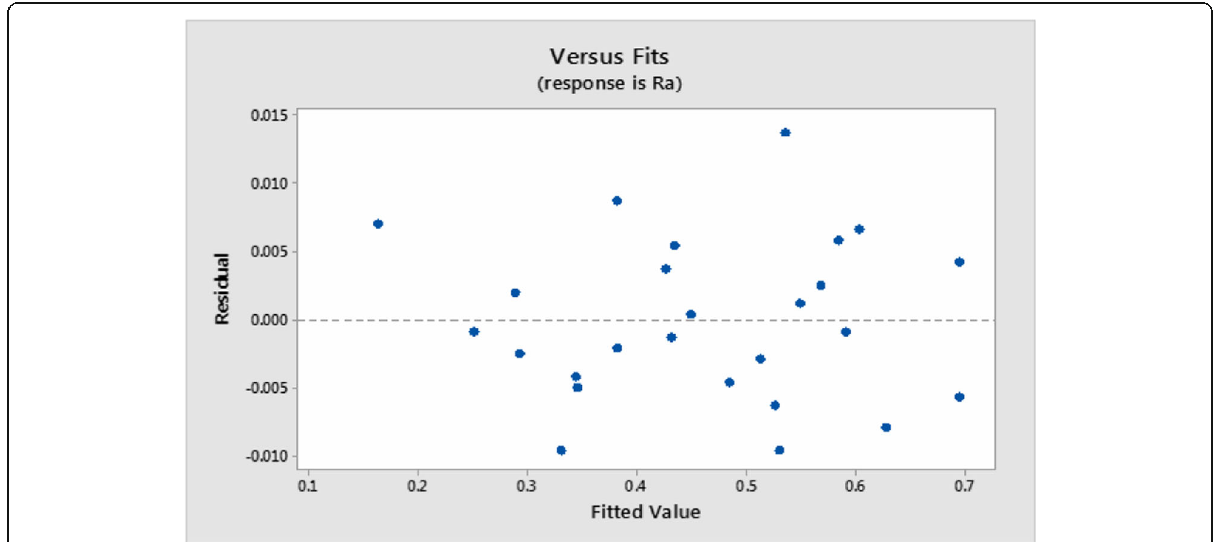
Fig. 3 Plot of residuals vs. predicted response for R